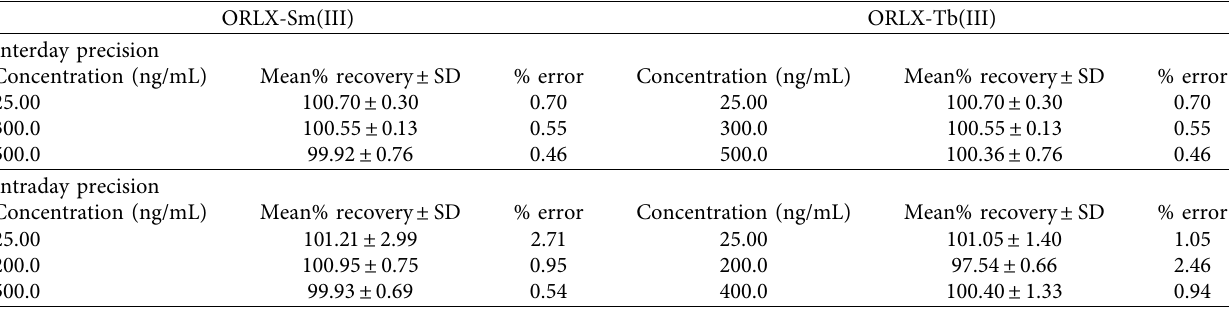
Table 8: Inter- and intraday precision for the determination of ORLX in the bulk powder using the optimum conditions.